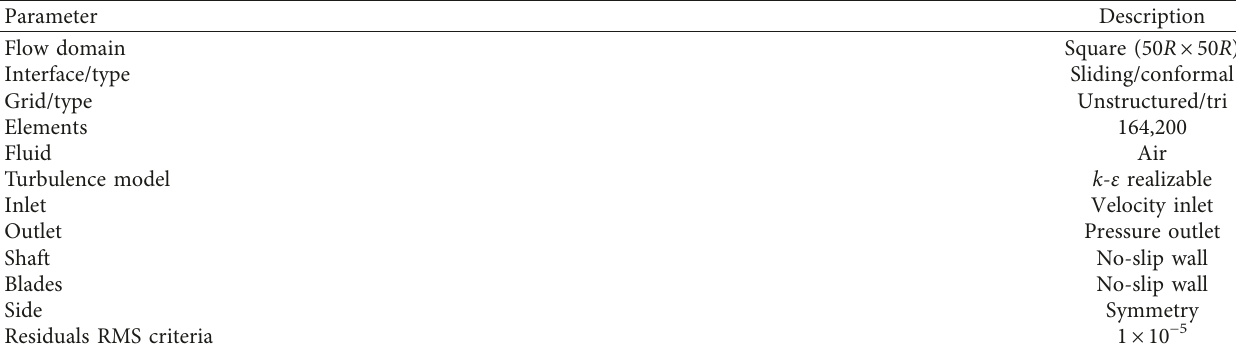
Table 2: Mesh and boundary conditions used in the current CFD work.